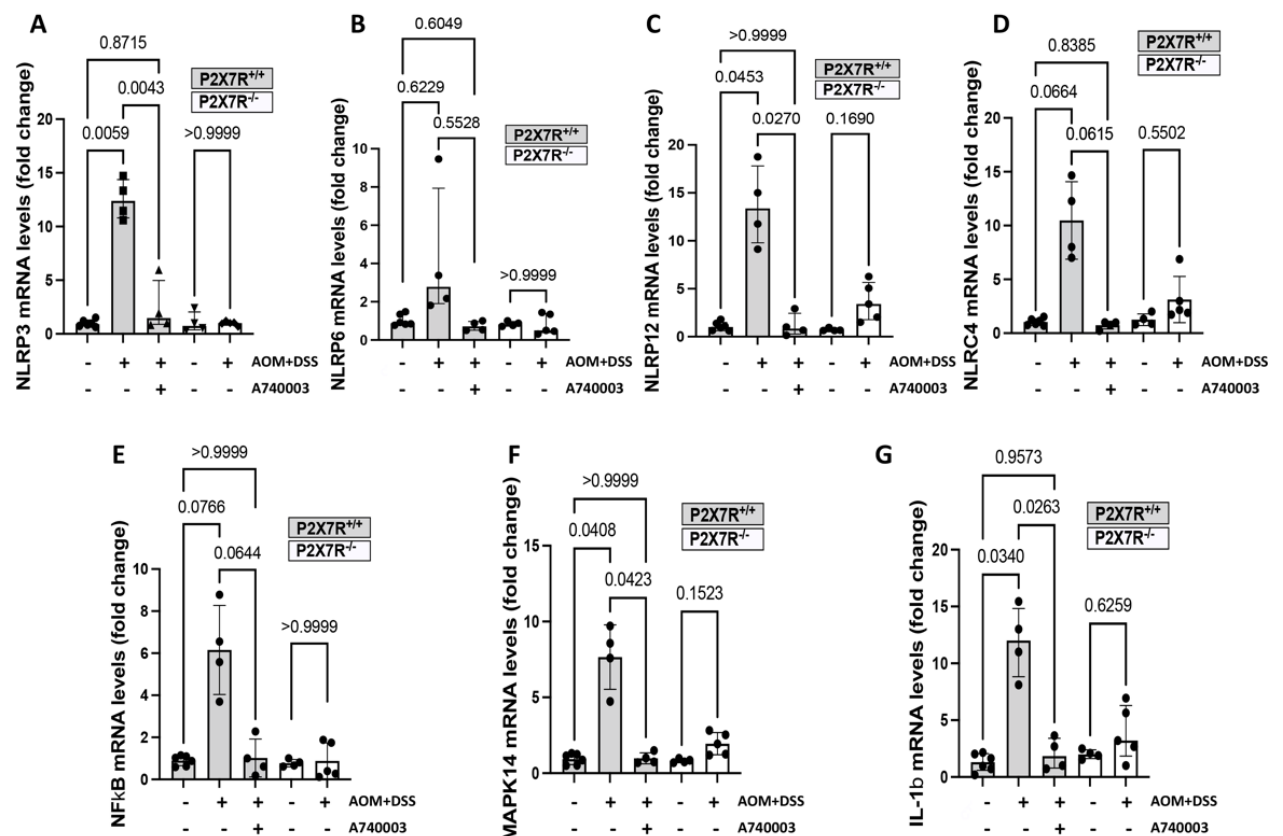
Figure 5. P2X7R blockade modulates the expression of genes related to inflammation and cancer in the colon. The mRNA levels measured by quantitative real-time PCR in colon samples of the P2X7R − / − and P2X7R +/+ mice treated with the P2X7R antagonist A740003 were significantly lower than those in the P2X7R +/+ -treated animals for the NLRP3 ( A ), NLRP12 ( C ), MAPK14 ( F ), and IL-1beta ( G ) genes. Other genes analyzed in this study did not show significant changes among the experimental groups ( B , D , E ). Values are medians with interquartile ranges of three independent experiments, with 3–4 animals per group. The analysis was performed by Brown-Forsythe and Welch ANOVA tests, in which multiple comparisons were carried out using Dunnett’s T3 test. Significant values are presented.